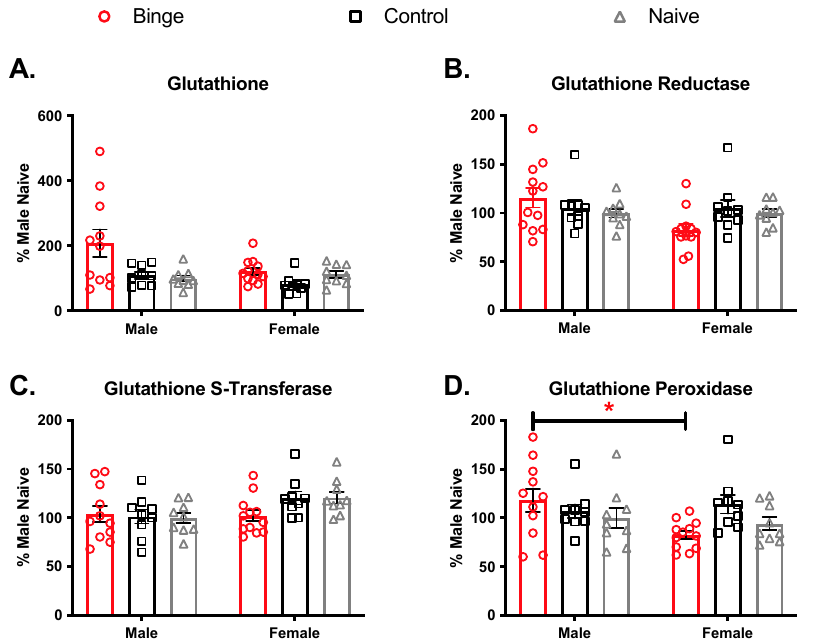
Brain Sci. 2021 , 11 , 1250 11 of 18 Figure 5. Effects of multiple binge in antioxidant capacity in the prefrontal cortex Binge alcohol Figure 5. Effects of multiple binge in antioxidant capacity in the prefrontal cortex Binge alcohol treatments increased glutathione (GSH) levels overall in the PFC ( A ). No significant effects were treatments increased glutathione (GSH) levels overall in the PFC ( A ). No significant effects were (F(1, 53) = 0.33, p = 0.56) or treatment (F(2, 53) = 0.87, p = 0.42). Additionally, for GST, there observed in PFC samples for ( B ) Glutathione reductase. There was a main effect of sex for Glutathi- observed in PFC samples for ( B ) Glutathione reductase. There was a main effect of sex for Glutathione was no significant interaction (F(2, 53) = 1.85, p = 0.16) and no main effects of sex (F(1, 53) one S-Transferase ( C ), with females having overall higher levels. For glutathione peroxidase ( D ), S-Transferase ( C ), with females having overall higher levels. For glutathione peroxidase ( D ), binged = 0.12, p = 0.72) or treatment (F(2, 53) = 0.87, p = 0.42). Finally, for GPx, there was no signif- binged males had higher levels than binged females. Bars depict ± SEM from percent naïve in (9– icant interaction (F(2, 53) = 1.10, p = 0.34) and no main effects of sex (F(1, 53) = 0.57, p = males had higher levels than binged females. Bars depict ± SEM from percent naïve in (9–12) animals. 12) animals. * p < 0.05. 0.39) or treatment (F(2, 53) = 0.06, p = 0.93). * p < 0.05. We assessed hippocampal GSH levels and antioxidant enzyme activities to deter- mine if repeated binge alcohol treatment changed the antioxidant capacity in a brain re- gion responsible for learning and memory (Figure 6). Analysis of GSH levels in the hip- pocampus showed a significant interaction (F(2, 53) = 6.79, p < 0.05) but no main effects of sex (F(1, 53) = 1.95, p = 0.17) or treatment (F(2, 53) = 0.48, p = 0.62). Tukey’s post-hoc tests revealed that male controls had higher GSH compared to male naïve ( p = 0.044). For GR, there was no significant interaction (F(2, 53) = 0.82, p = 0.45) and no main effects of sex